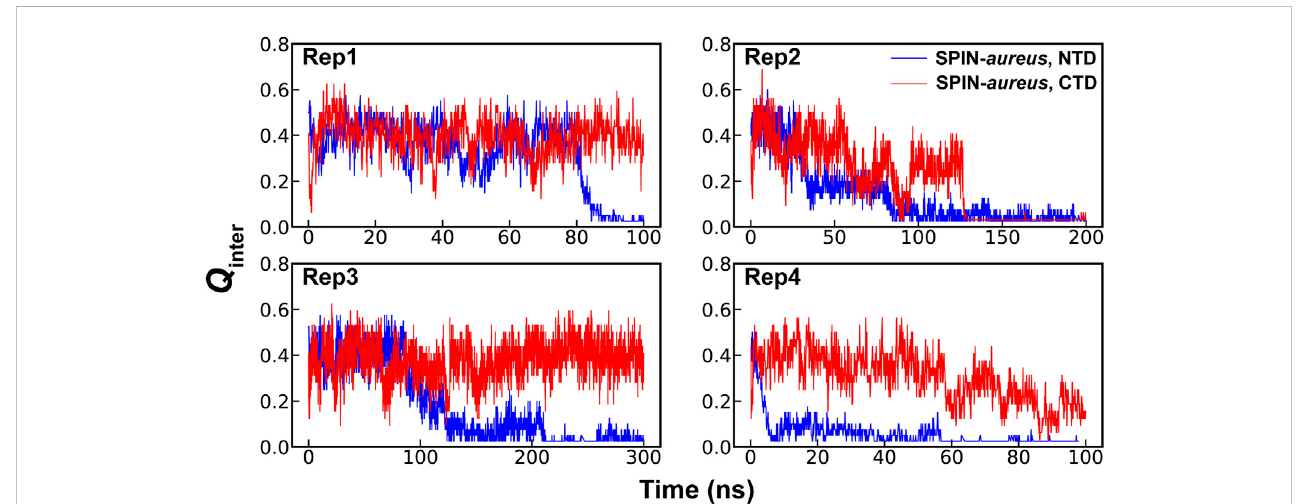
FIGURE 2 FractionsofnativeintermolecularcontactsbetweentheNTD(blue)andCTD(red)ofSPINduringfourindependentsimulationsoftheSPIN- aureus /MPO complex at 450 K.